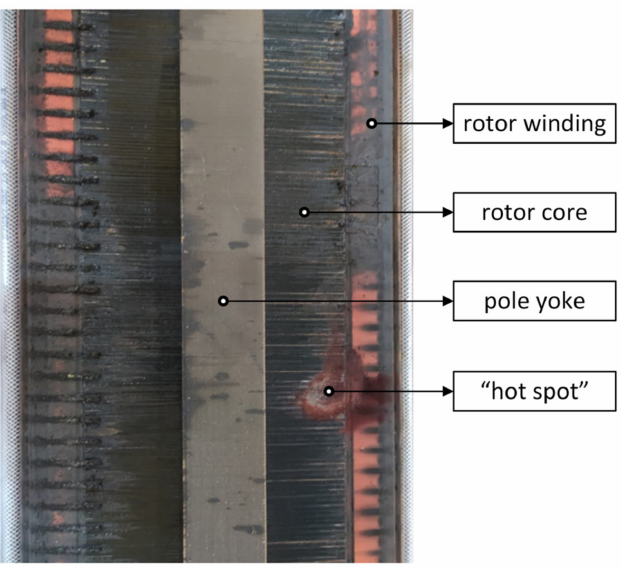
Figure 10. Rotor core hot